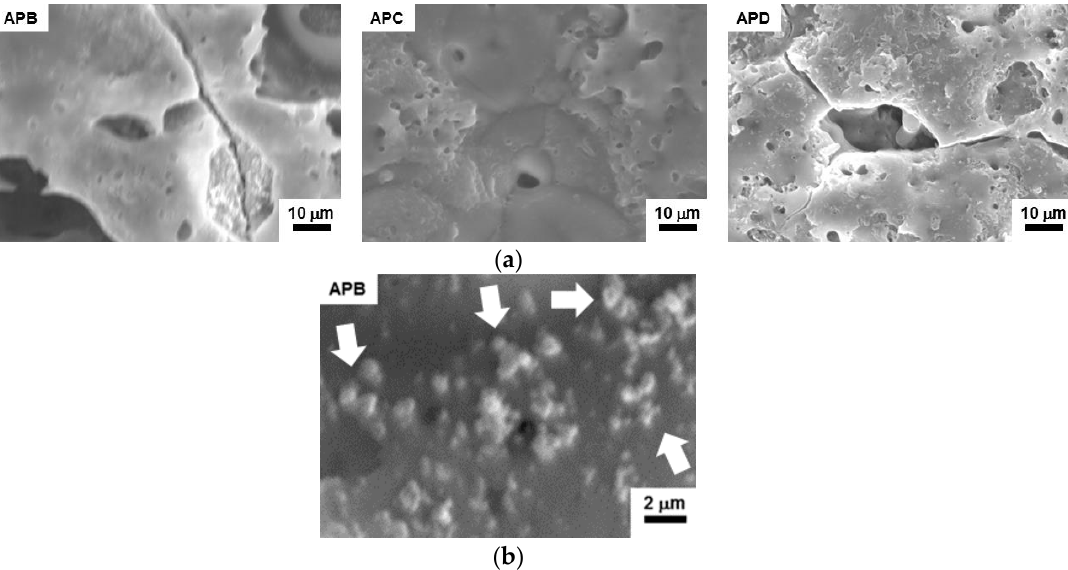
Figure 7. High magnification surface morphologies of ( a ) APB, APC and APD coatings on the highlighted sections in Figure 6 and ( b ) clusters of Si 3 N 4 nanoparticles (indicated by arrows) on APB coating.